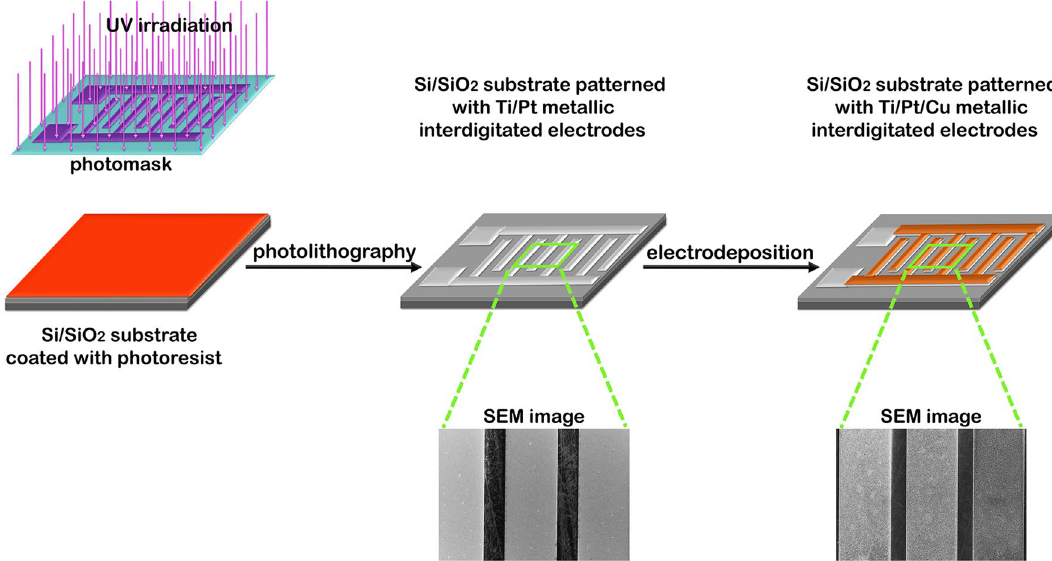
Figure 1. Schematic representation of the main steps implicated in the fabrication of the Ti/Pt/Cu metallic interdigitated electrodes on Si/SiO 2